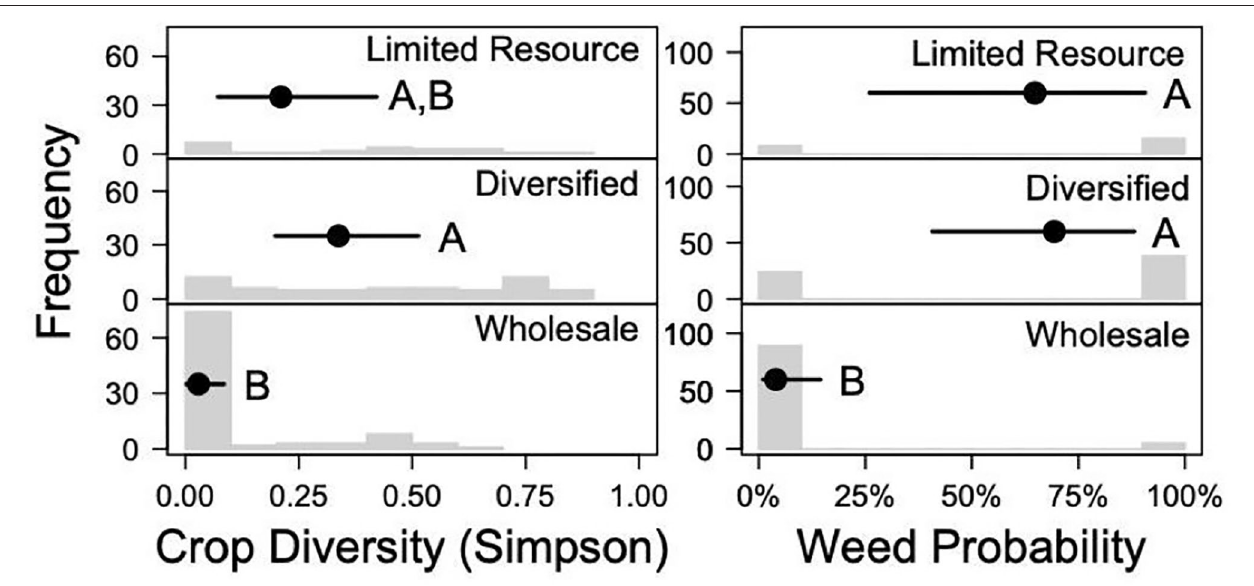
FIGURE 2 | Effects of farm types on crop diversity and “weediness.” Left panels: Crop diversity (Simpson index) was significantly higher on diversified than wholesale farms, whereas limited resource farms grew only marginally more diverse crops than wholesale farms. Right panels: The probability that weeds occupied > 5% cover within at least one crop type was also much higher on limited resource and diversified farms than on wholesale farms. Gray histograms depict distribution of raw data. Solid black points and lines indicate estimates and 95% confidence intervals from linear mixed models; letters denote significance under Tukey posthoc tests.